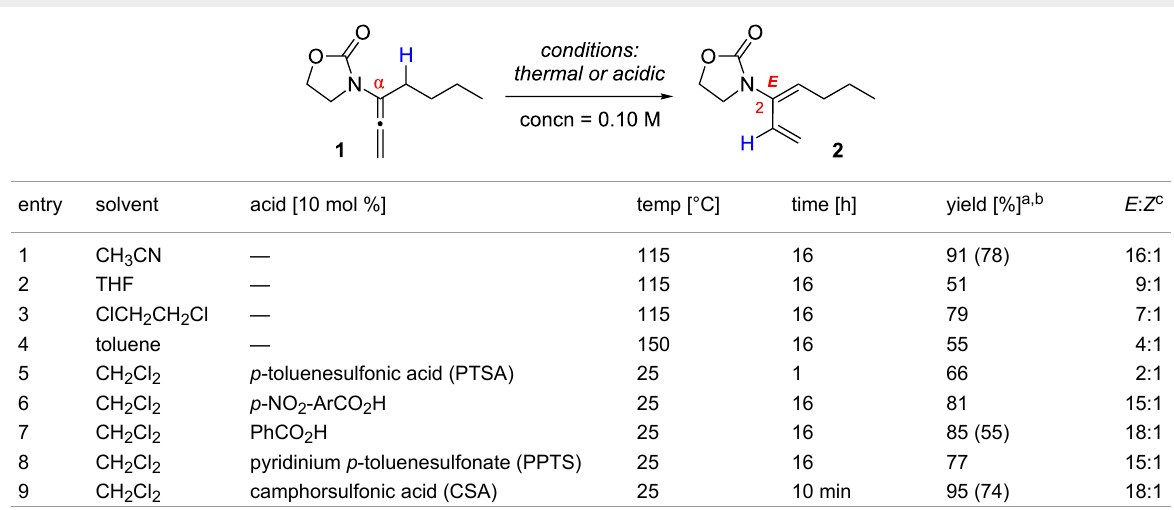
Table 1: 1,3-Hydrogen shift of allenamides.